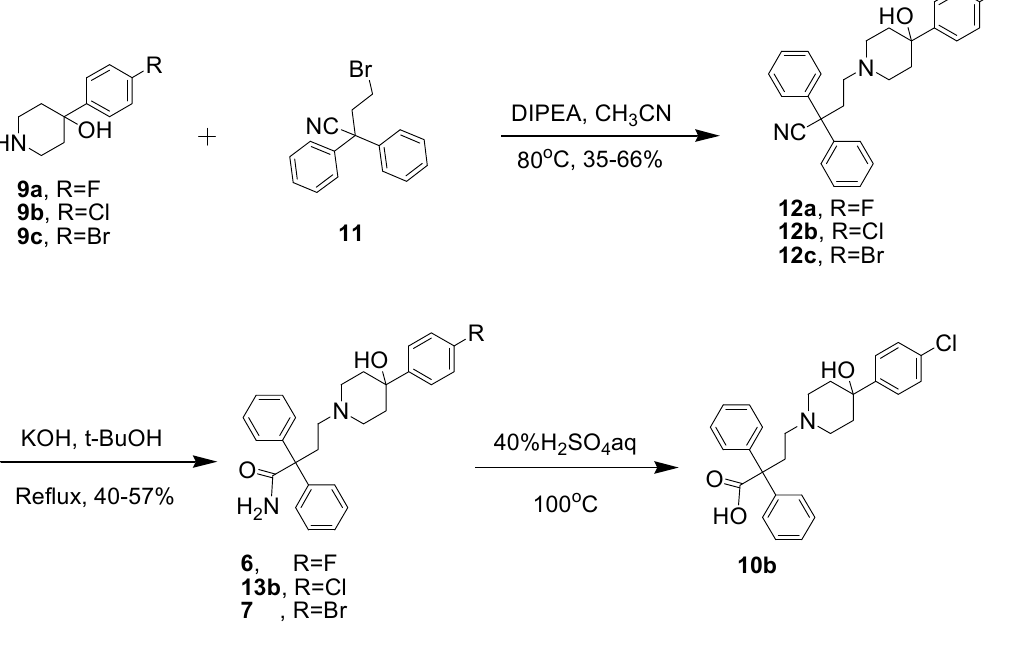
Table 2. Hydrolysis of the nitrile 12b